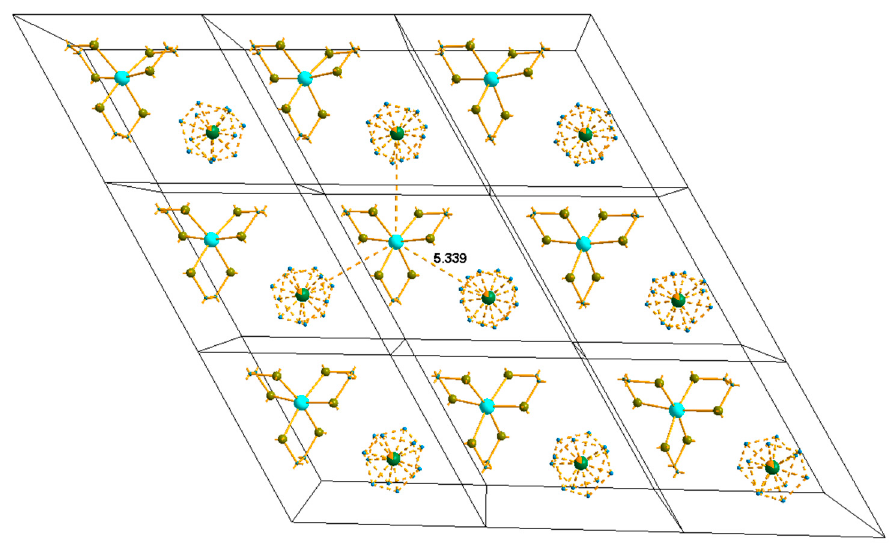
Figure 2. Model of anion disordering in a layer perpendicular to the c axis for crystal No 6. The Mo/W ratio is shown as a pie chart in the place of the corresponding atom (green is W and yellow is Mo).